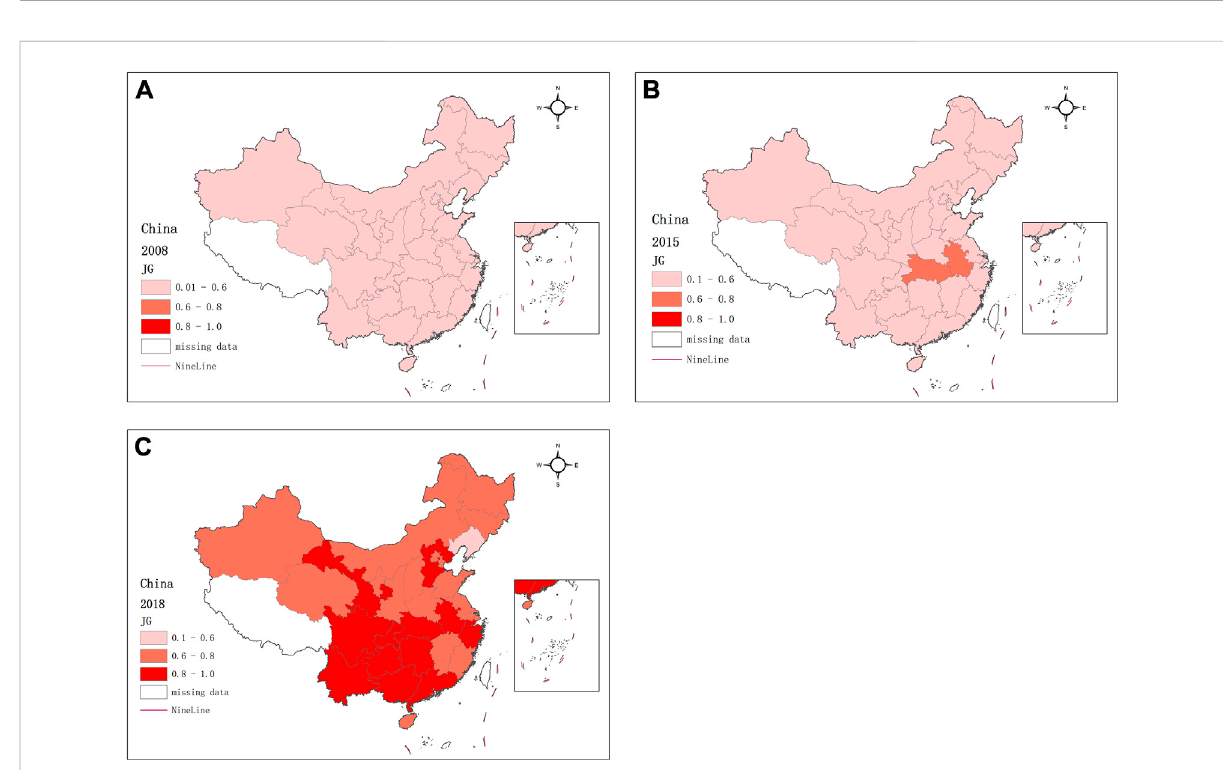
FIGURE 3 Spatial and temporal evolution of high-quality economic